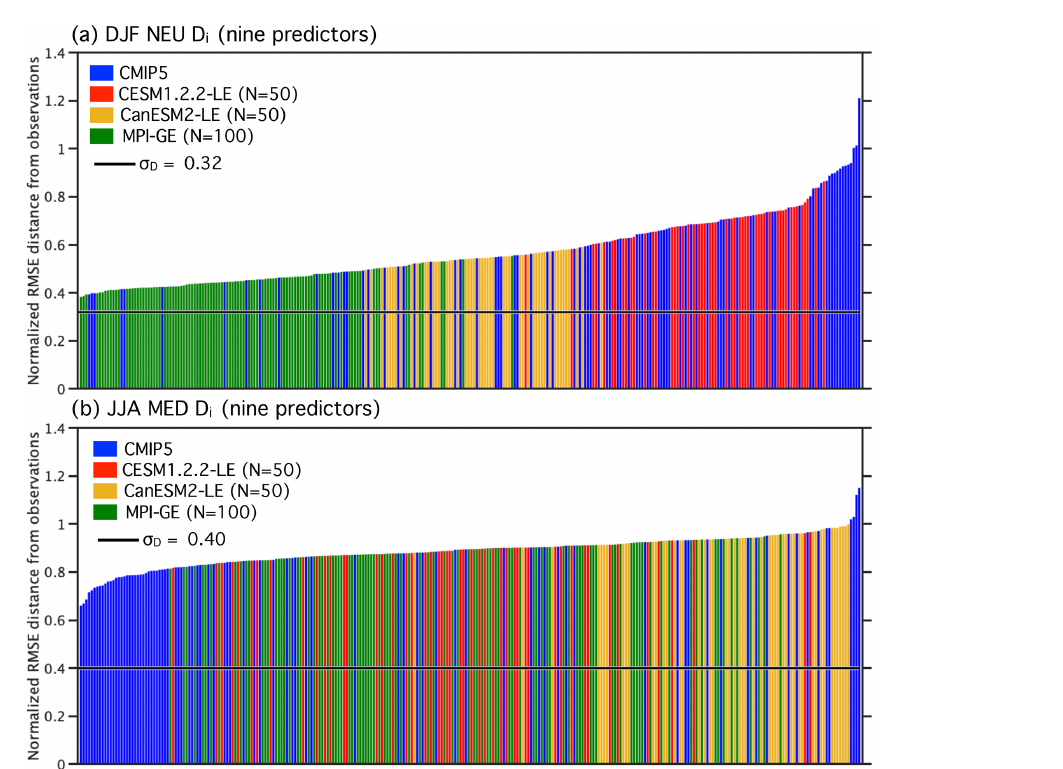
Figure B1. RMSE distance D i , derived from nine predictors, between observations and the 288 members of the ALL ensemble – CMIP5 (blue) + CESM1.2.2-LE (red) + CanESM2-LE (yellow) + MPI-GE (green). DJF NEU distances are shown in (a) , and JJA MED distances are shown in (b)